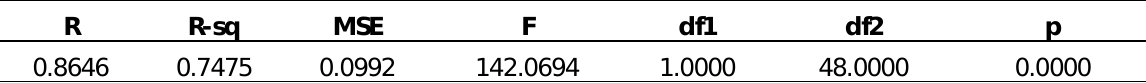
Model Summary of HCSQ Affecting Patient Satisfaction (R 2